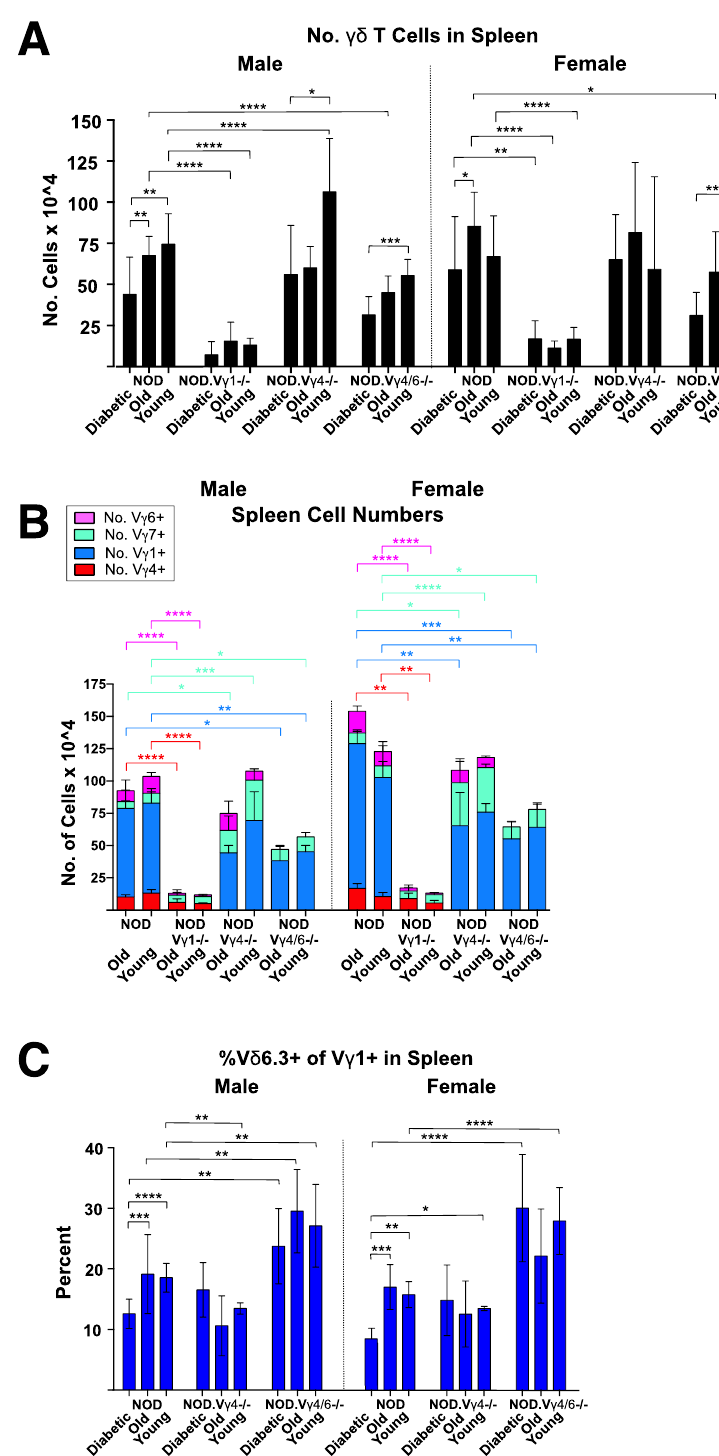
Figure 7. Analysis of γδ in the spleens of NOD-V γ -deficient mouse strains, compared to those of wt NOD controls. See Figure 6 legend for description of mice used. ( A ). Average number of γδ T cells obtained per spleen. ( B ). The average number of cells obtained of each V γ -defined γδ T cell subset from spleens. ( C ). Mean percentage of spleen V γ 1+ γδ T cells that co-expressed V δ 6.3. * p < 0.05, ** p < 0.01, *** p < 0.001, and **** p < 0.0001.